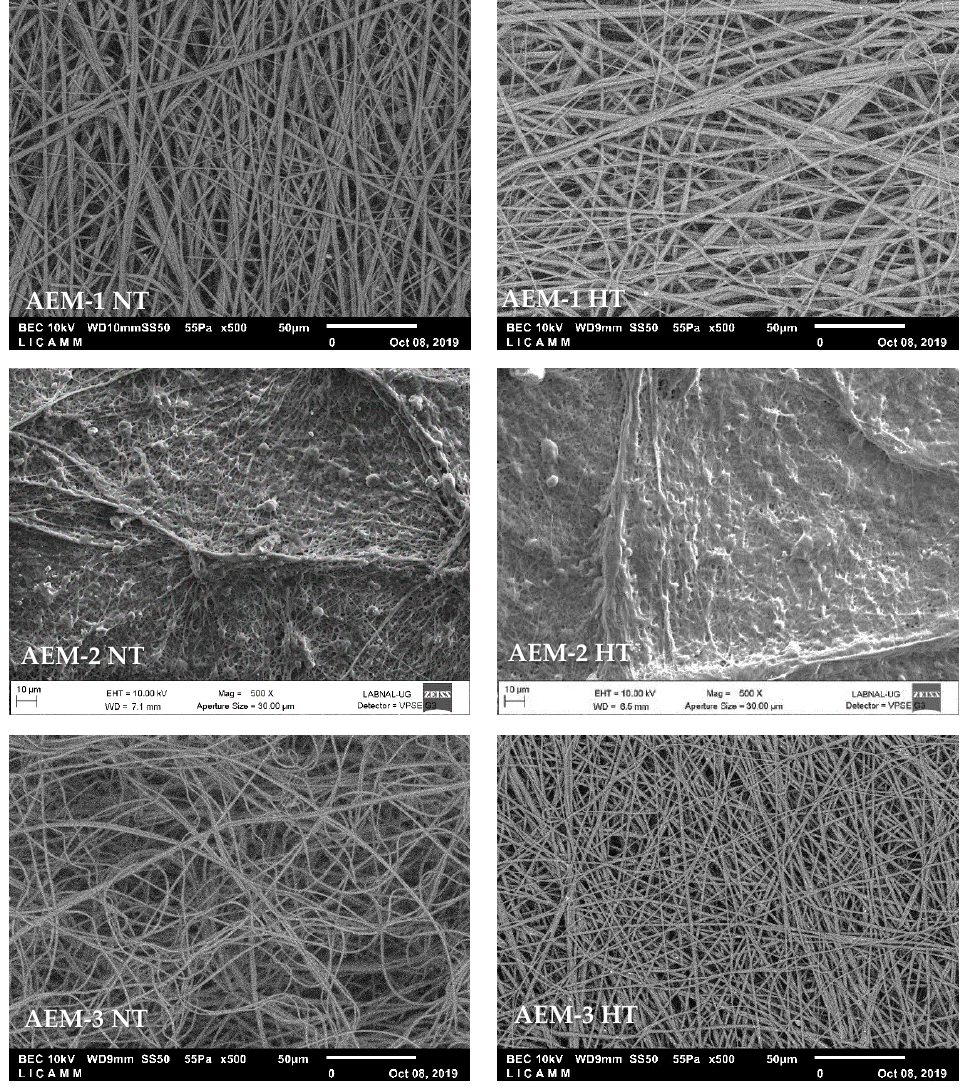
Figure 1. Scanning electron microscopy (SEM) images of the surface of the anion exchange mem- branes (AEMs) without heat treatment (NT, left side) and with heat treatment (HT, right side) with a magnification of ×500.